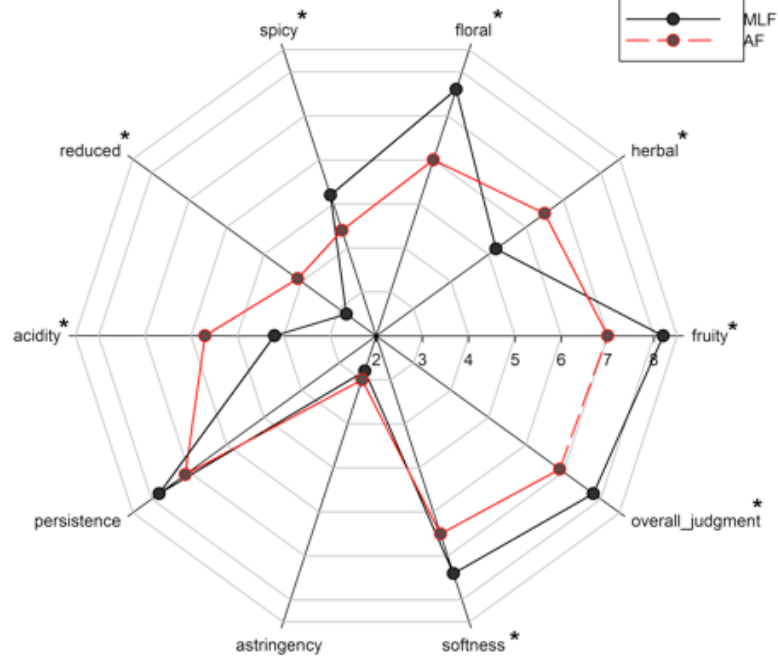
Figure 5. Radar plot of Fiano wine obtained by sequential inoculum strategy with M10 cells pre-adapted to acid stress. The two samples evaluated come from Batch D, at the end of alcoholic fermentation (AF) and at the end of malolactic fermentation (MLF). * indicates significant differences ( p < 0.05) of attributes between AF and MLF.